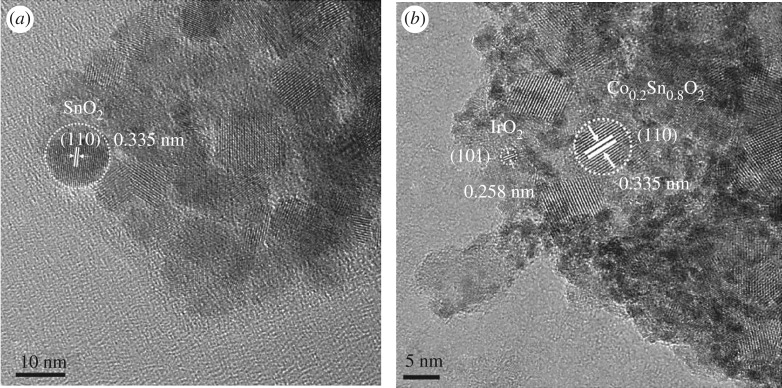
HR-TEM images of (a) SnO2 and (b) 40IrO2/Co0.2Sn0.8O2.